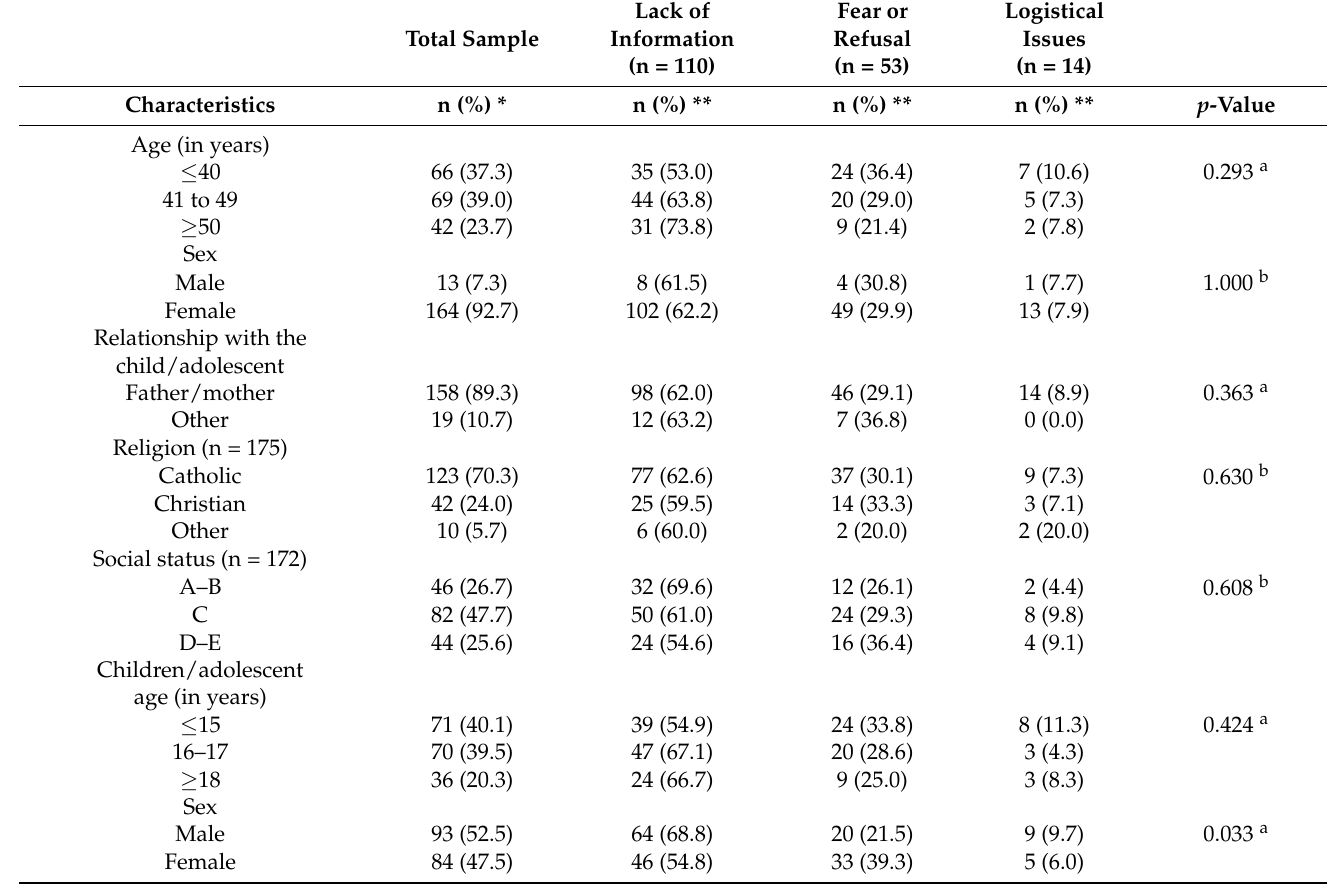
Table 3. Sociodemographic characteristics of parents or guardians of children and adolescents not vaccinated against HPV; total sample, according to main reason for non-vaccination (n = 177). Logistical Fear or Lack of Issues Refusal Total Sample Information (n = (n = 53) (n = 110)